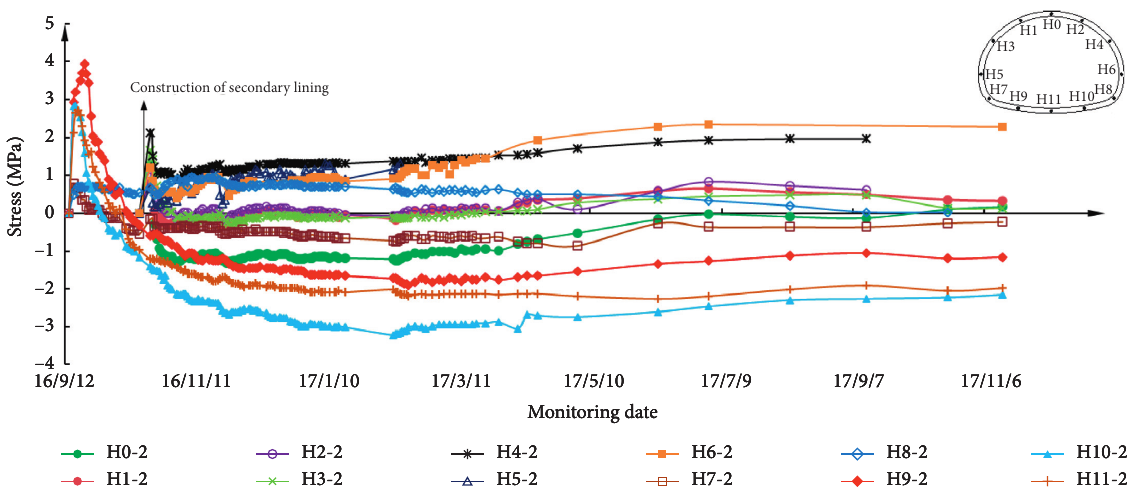
Figure 22: Time curve of secondary lining concrete (inside) in YK2+133 section.